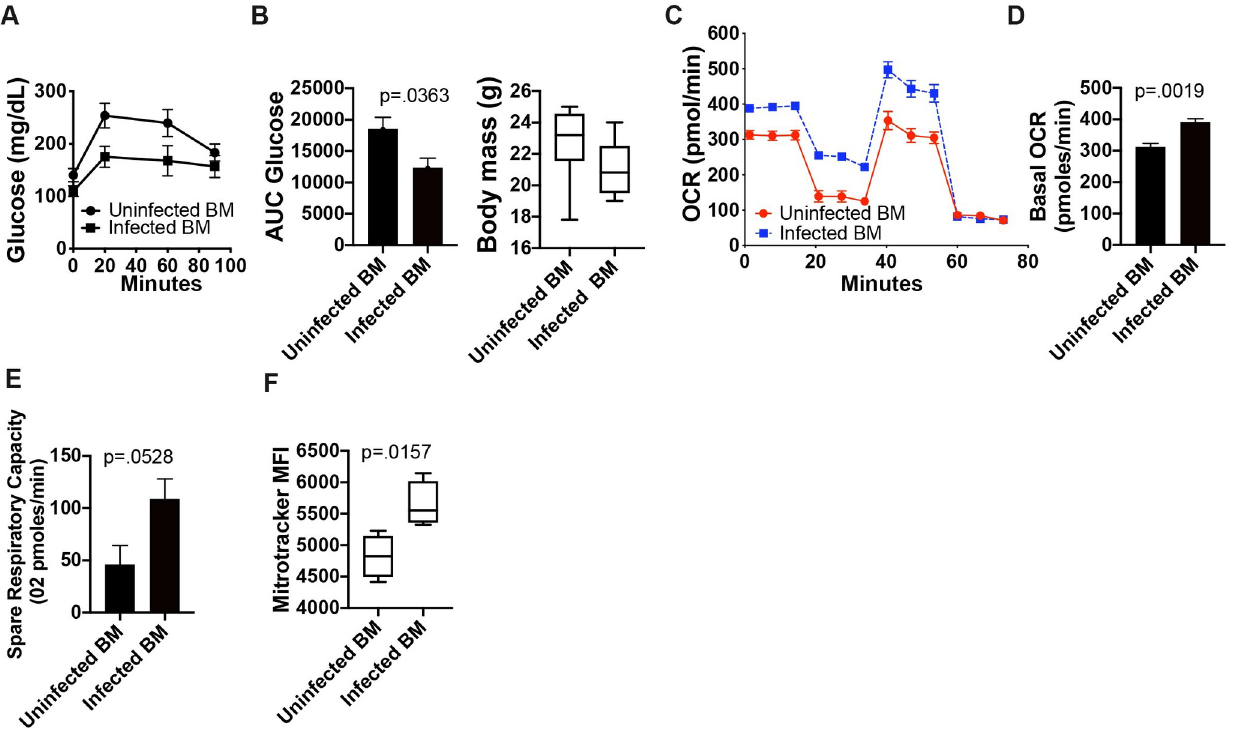
Fig 5. S . mansoni induced modulation of male macrophage metabolism is long-lived in the absence of antigen. Bone marrow from 10-week S . mansoni infected or control ApoE -/- mice on HFD was transferred into busulfan treated ApoE -/- recipients on HFD. A,B) Glucose tolerance test (GTT) and total body weight at 10 weeks post-transfer. GTT values were analyzed by Area Under the Curve using GraphPad Prism. C-E) OCR and spare respiratory capacity were measured at steady state in 7-day BMDM. F) MitoTracker Red Deep Stain measure by flow cytometry in BMDM. Data is two combined experiments with 7–8 animals per group. Statistical analysis was done using Welch’s